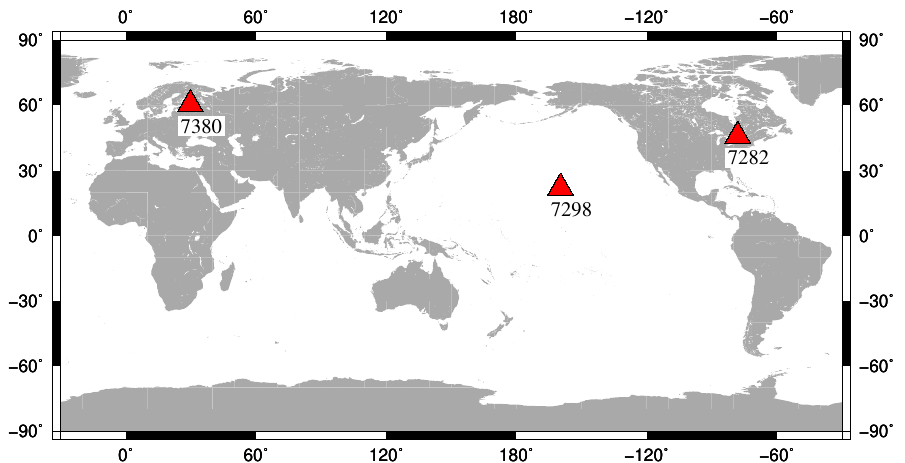
Figure 6. Station distribution of a session of less than five stations. The red triangle represents the VLBI station and its station code in the white box.